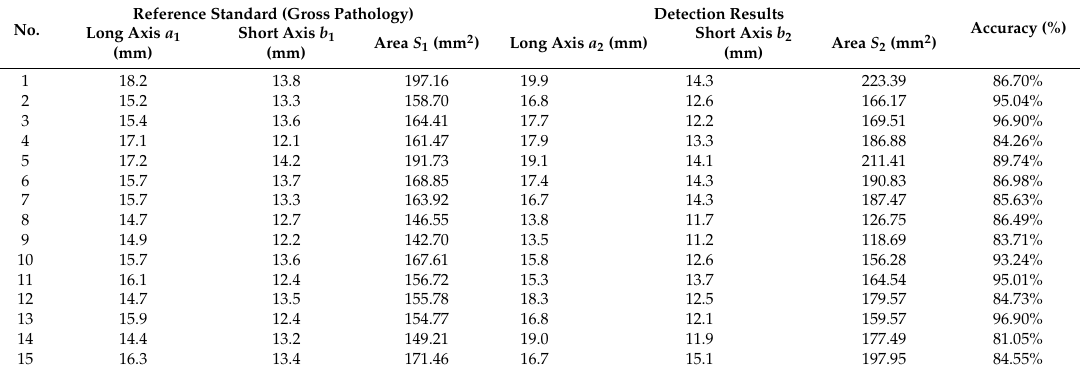
Table 1. Validation results of thermal lesions ( P = 80 W; t = 60